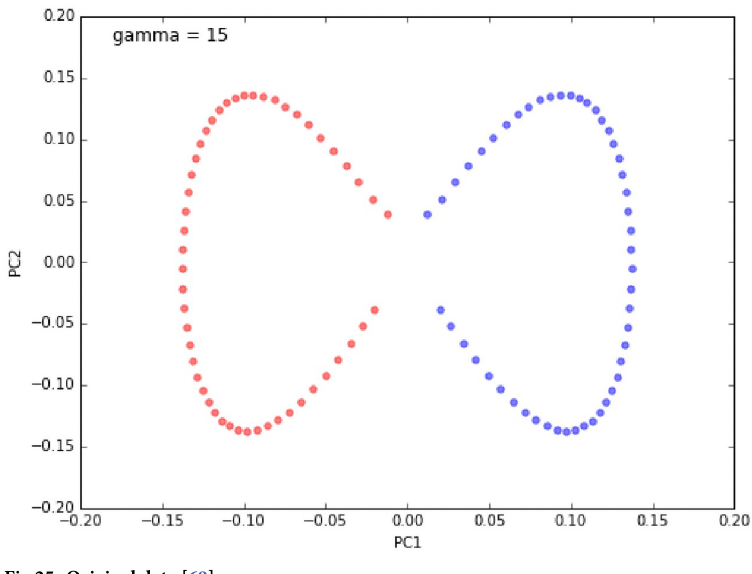
Fig 25. Original data [69].